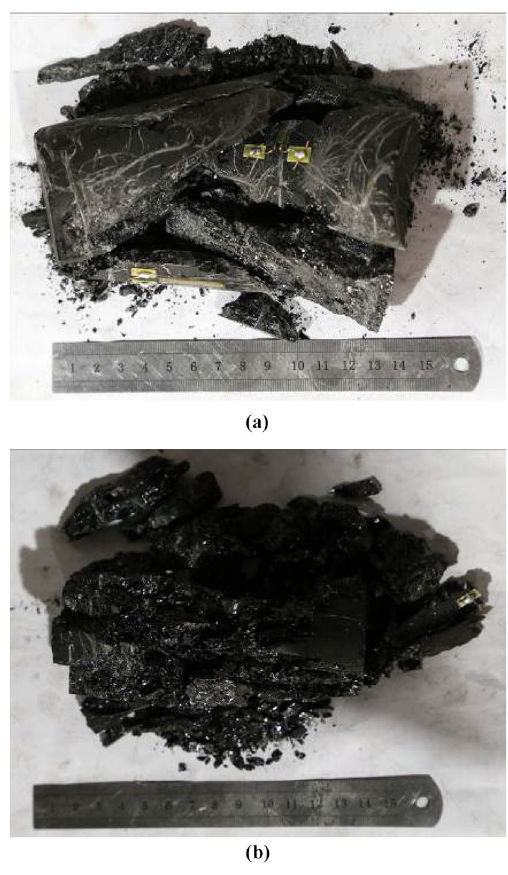
Fig. 8 Broken pictures of coal. a Grade loading. b Cyclic